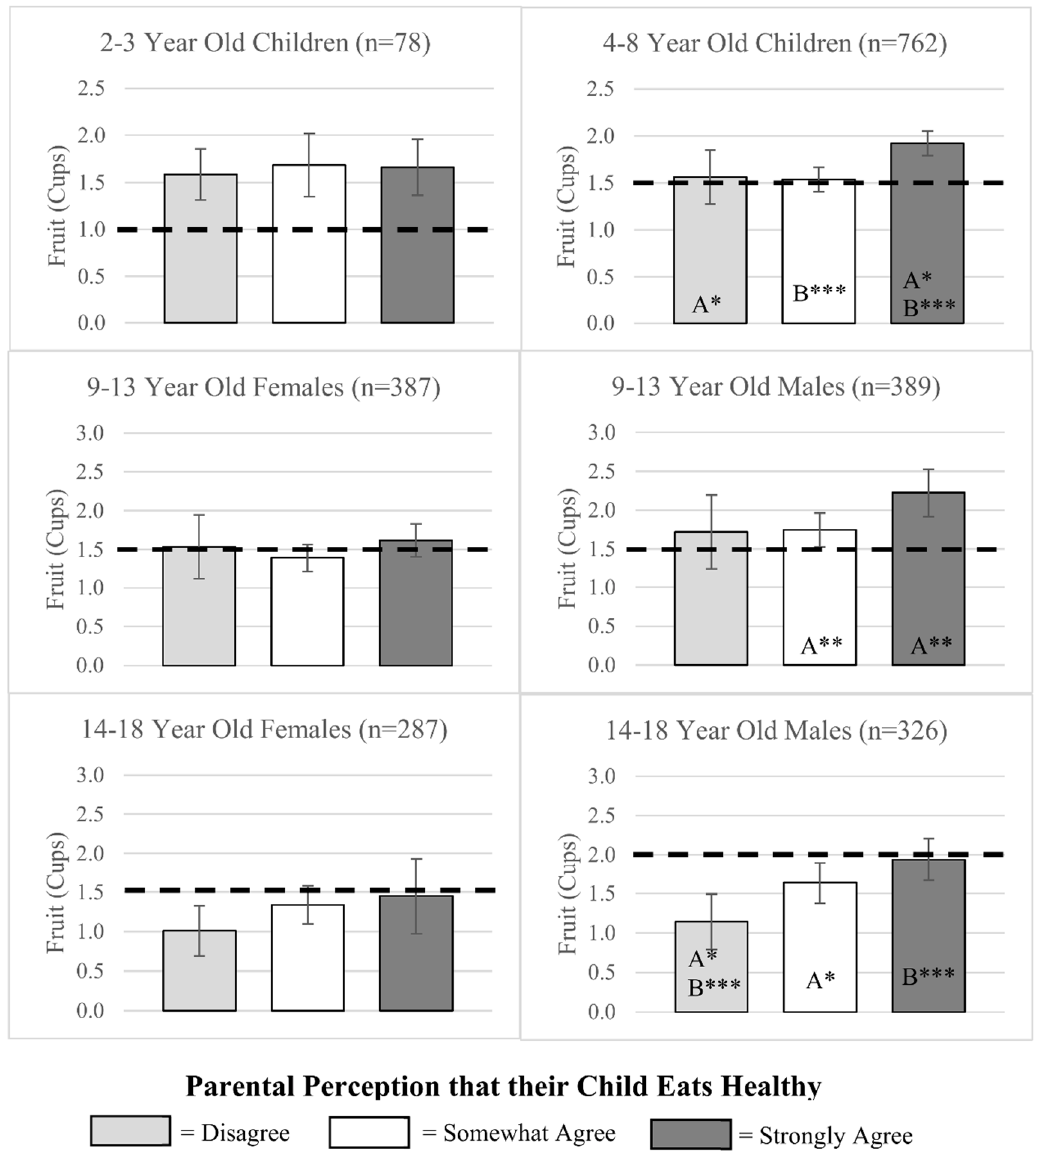
Figure 2. Children’s fruit consumption across parental perception categories. Notes. Results from multivariate regression analysis showing adjusted average cups of fruit consumed by parental perception of children’s diet categories. Models included parental perception, sex, age, parental education, federal poverty level, race/ethnicity, SNAP participation, and WIC participation. Bars with the same letter (A, B, or C) represent significant differences in consumption across those perception categories (* p ≤ 0.05; ** p ≤ 0.01; *** p ≤ 0.001). MyPlate recommendations for each age and sex category are represented by black dashed lines.